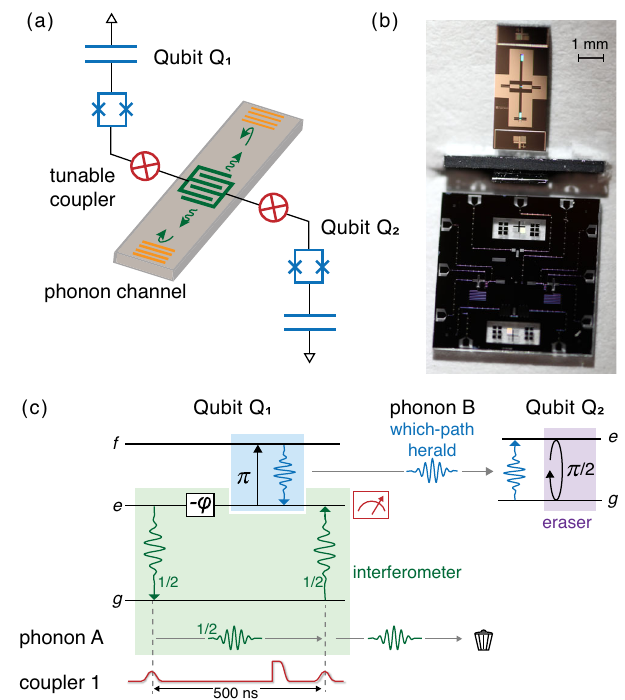
FIG. 1. Experimental setup and quantum eraser scheme. (a) Two transmon superconducting qubits (blue) are coupled to a surface acoustic wave phononic channel (gray) via a central interdigitated transducer (IDT, green), using which both qubits can emit and capture itinerant phonons. The IDT is placed between two reflective mirror gratings (orange) that define a Fabry-Perot cavity and reflect phonons within the mirrors ’ bandwidth back toward the IDT. Two tunable couplers (red) are used to dynamically control the coupling between the qubits and the IDT, allowing shaping the wave packets of emitted phonons, and ensuring their efficient reabsorption after com- pleting the 500 ns acoustic round-trip. The couplers also enable the controlled partial release of phonons. (b) Optical micro- graph of the device, showing (top) the acoustic Fabry-Perot structure on a lithium niobate chip, (bottom) the two super- conducting qubits and associated superconducting wiring on a separate sapphire chip, and (middle) a side view of the flip-chip assembled device. (c) When one of the qubits ( Q 1 ) swaps a half-phonon ( A ) into the acoustic channel, an interferometer can be implemented (green box): once A completes a round-trip within the acoustic cavity, its reabsorption probability by Q 1 depends on the relative phase accumulated by Q 1 and A , and leads to interference in Q 1 ’ s final excitation probability. To implement a quantum eraser, we generate an entangled phonon herald marking the which-path information by generating a second, entangled phonon ( B ) conditionally on Q 1 being in j e i (blue box): this suppresses the interference. Capture and detection of the entangled herald B by Q 2 acquires the which-path information after the interference of Q 1 and A is complete, making this a time-delayed herald. Subsequently applying a π = 2 pulse to Q 2 equalizes its j g i and j e i populations, erasing the which-path information and restoring the interference, thereby completing a delayed quantum eraser